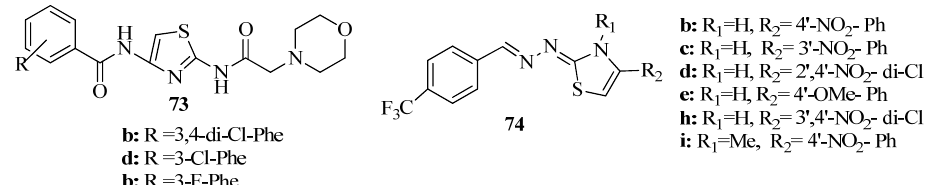
Figure 28. Structures of substituted 2-amino-4-phenylthiazole derivatives and (Z)-3,4-disubstitutedl-2-((E)-(4-(trifluoromethyl) benzylidene) hydrazono)-2,3-dihydrothiazole.